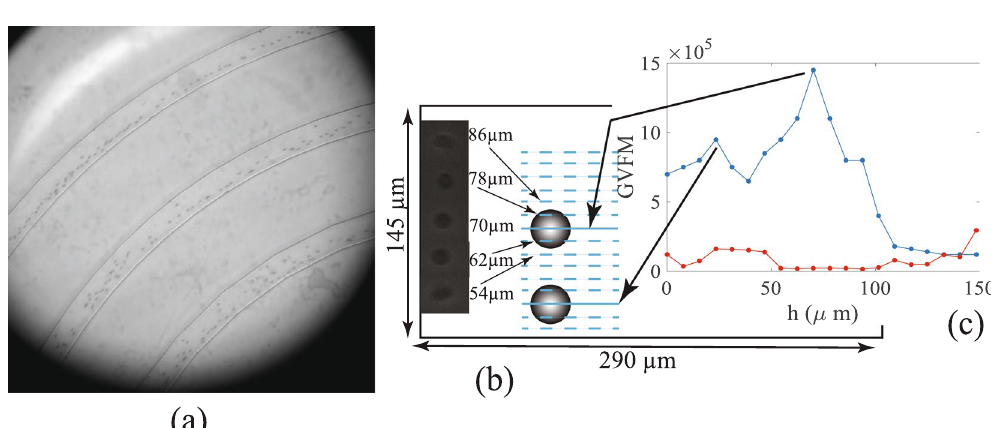
Figure 2. ( a ) A sample image of particles focused in the outermost spiral arm. ( b ) Sample images of particles at different heights in the vertical stack. ( c ) The right panel shows the average GVFM of images of particles at different heights by the (top) blue curve. The (bottom) red curve is average GVFM at different heights in the absence of particles. The local maxima in the top curve indicate the heights at which the particles are best